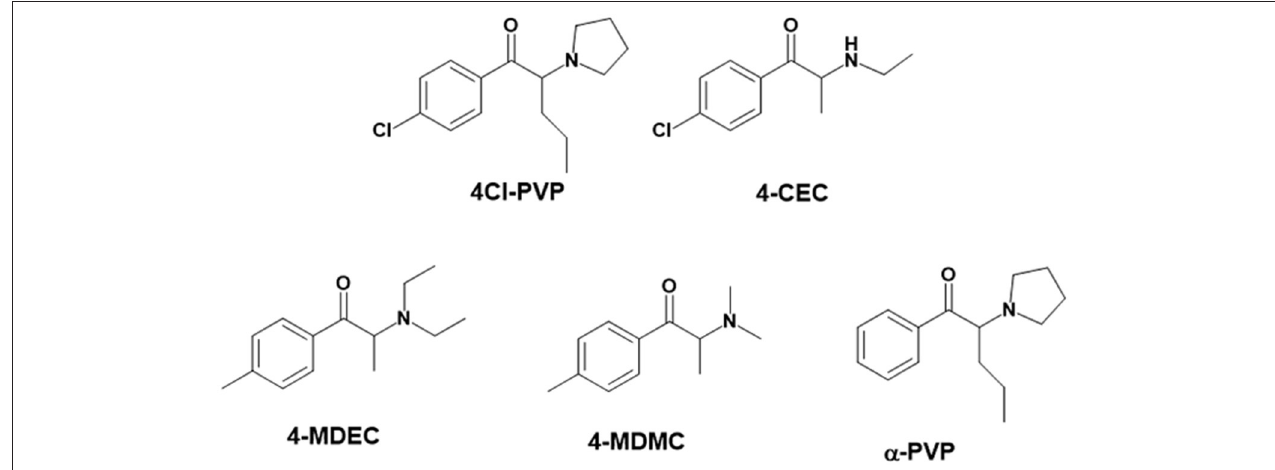
FIGURE 1 | Structures of the synthetic cathinones used in the current